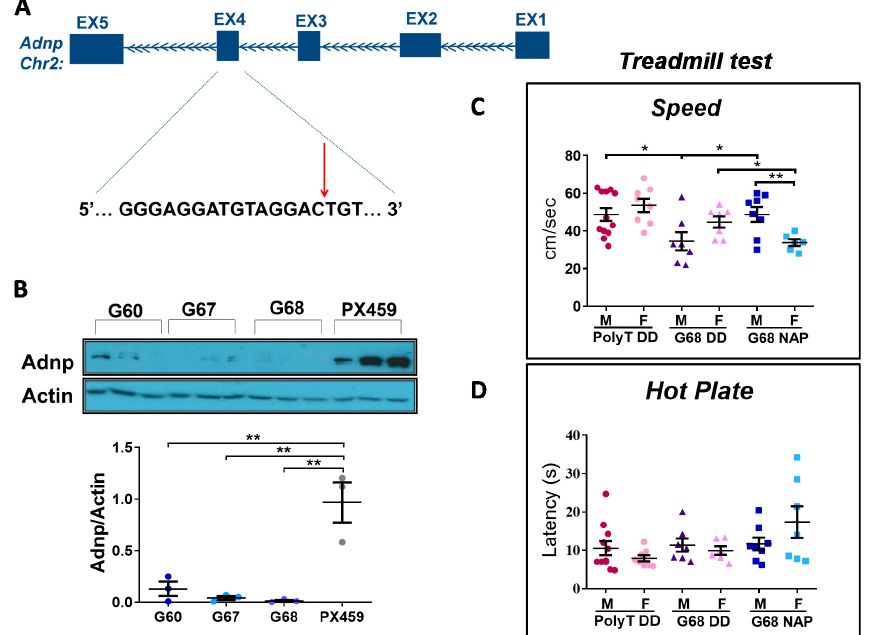
Figure 7. CRISPR/Cas9-mediated knockdown to the Adnp gene. ( A ) A schematic representation of the targeted second coding exon (exon No.4) of the mouse Adnp gene sequence. The 18-nucleotide sgRNA target sequence is depicted in black, and the red arrowhead indicates the Cas9 cleavage site. ( B ) A successful knockdown of Adnp in culture by the CRISPR-Cas9 technology: NIH 3T3 cells were transfected with PX459 plasmid, encoding 3 different Adnp sgRNA (termed 60, 67, 68), and an empty plasmid as control (termed PX459), the protein was extracted and subjected to Western blotting (staining with an ADNP antibody and normalized to Actin. One-way ANOVA followed by a Tukey post hoc test revealed that all sgRNA induce a significant knockdown ( n = 3, ** p = 0.002, ** p = 0.001, ** p = 0.001 for 60, 67, 68 respectively). sgRNA 68 showed the most profound knockdown with a 98.65% reduction in ADNP protein levels, compared with control. All sgRNAs targeted the second coding exon (exon No.4) of ADNP. sgRNA sequences were as follows: 68: 5 (cid:48) -GGGAGGATGTAGGACTGT-3 (cid:48) , 67: 5 (cid:48) -CAGTCCTACATCCTCCCATG-3 (cid:48) , 60: 5 (cid:48) -AACACTACATGGGAGGATGT-3 (cid:48) . ( C ) Treadmill test: A significant reduction in maximum running speed was observed in the G68 male mice group compared to Poly T DD (* p < 0.05) and NAP-treated G68 mice (* p < 0.05). Poly T (males n = 12; females n = 8), G68 DD (males n = 7; females n = 7) and G68 NAP groups (males n = 8; females n = 7). Furthermore, sex di ff erences were found in the G68 NAP-treated group (** p < 0.01). ( D ) No significant di ff erences were observed in the hot plate test. Analysis was performed by using an unpaired Student’s t -test. Poly T (males n = 12; females n = 8), G68 DD (males n = 7; females n = 7) and G68 NAP groups (males n = 8; females n =